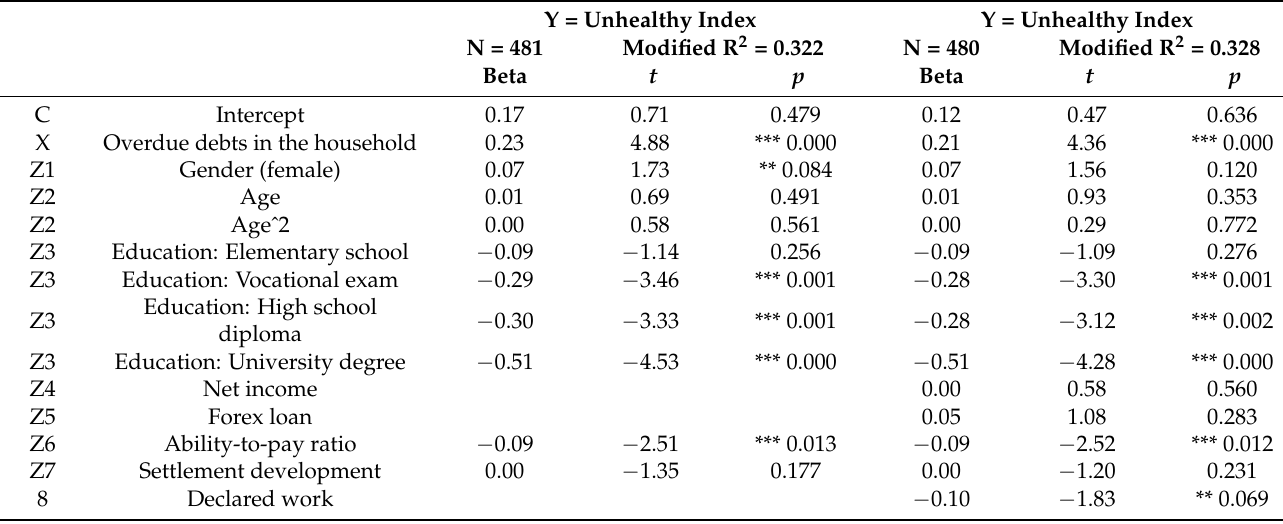
Table 5. Overdue debts and